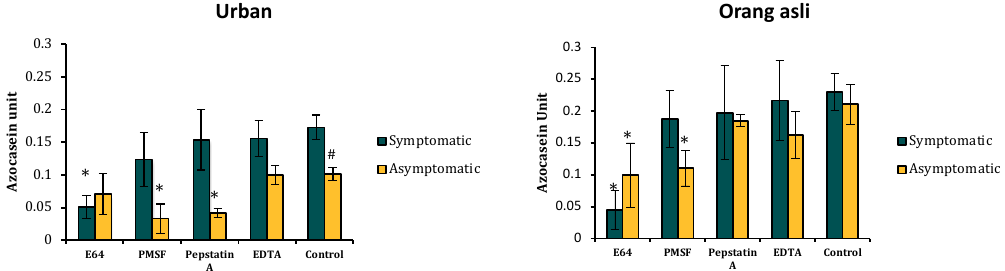
Figure 6. The specific type of protease activity of Blastocystis sp. isolated from urban and orang asli individuals. Note the predominance of cysteine protease in symptomatic and serine protease in asymptomatic isolates. Values are expressed as mean ± SD. * p < 0.05, Student’s t -test comparing the mean to control. # p < 0.05, Student’s t -test comparing the mean protease activity between symptomatic and asymptomatic.